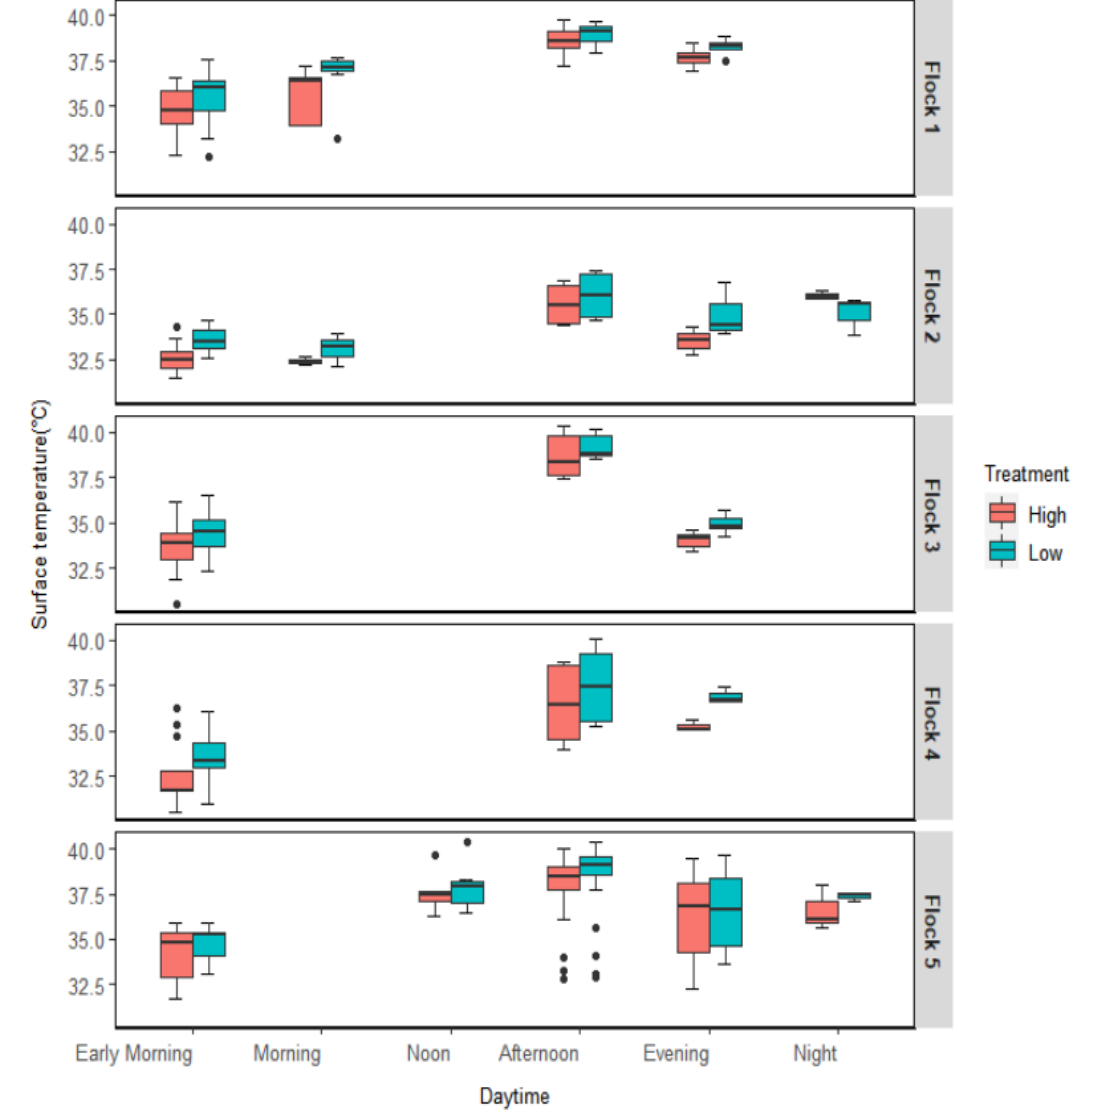
Figure 5. Diurnal variation of heavy broilers’ surface temperature variation under two AV treatments.